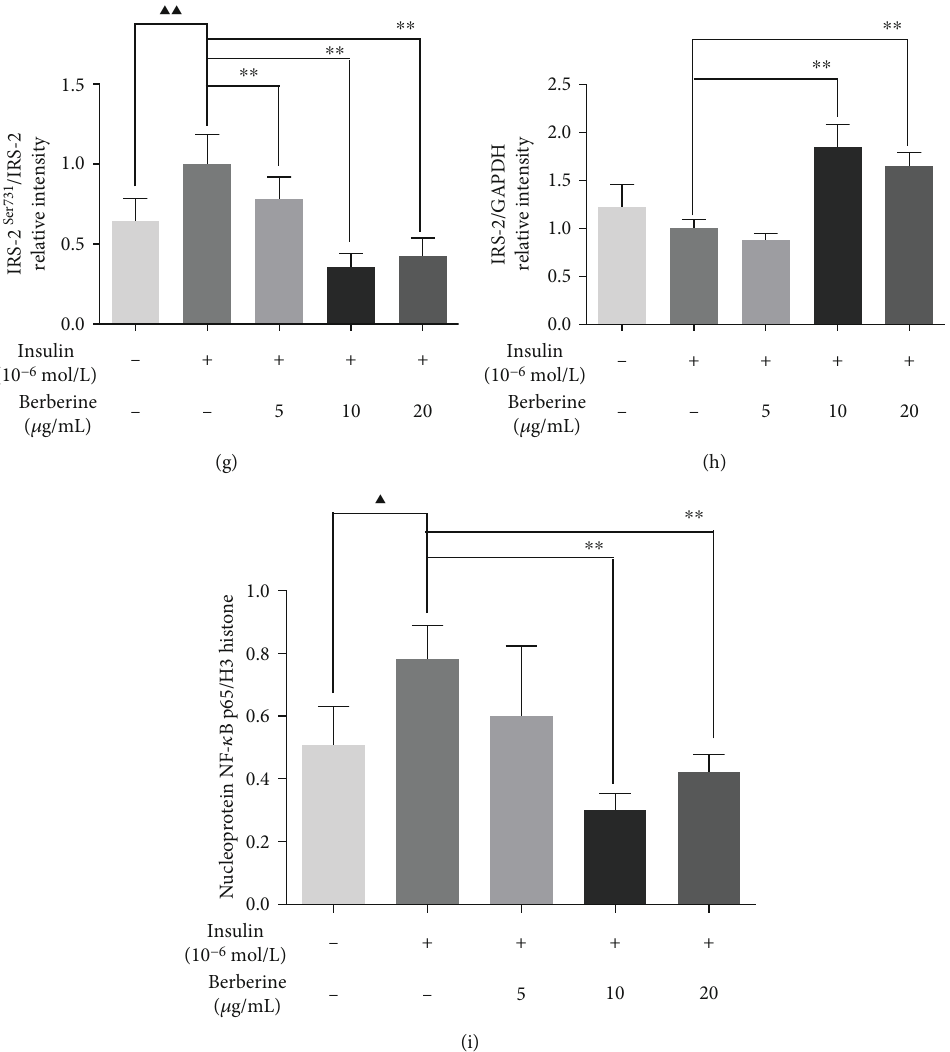
Figure 9: E ff ect of BBR on the PI3K/AKT pathway in HepG2-IR cells. (a) Representative Western blotting results of PI3K p85, pAKT Ser473, AKT, pIRS-1 Ser307, IRS-1, pIRS-2 Ser731, IRS-2, and nucleoprotein NF- κ B p65. (b – i) Semiquantitative analysis of PI3K p85, pAKT Ser473, AKT, pIRS-1 Ser307, IRS-1, pIRS-2 Ser731, IRS-2, and nucleoprotein NF- κ B p65. The experiments were repeated three times and presented as mean ± SD . ▲ P < 0 : 05 and ▲▲ P < 0 : 01 , Con vs. model; ∗ P < 0 : 05 and ∗∗ P < 0 : 01 , model vs. BBR-treated